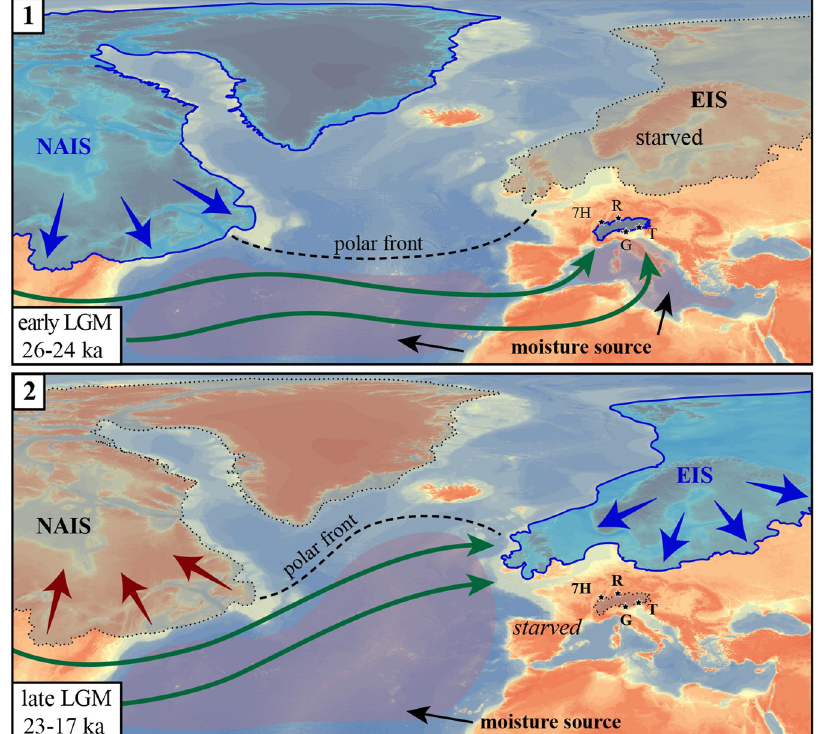
Figure 4. Schematic synthesis of the two phases of the LGM: (1) the topography of the NAIS produced changes in atmospheric circulation forcing the jet stream (green arrows) over southern Europe and the Mediterranean, which became an additional moisture source increasing precipitation over the Alps triggering synchronous Alpine glaciers advance; whereas the EIS waxing was slowed down. (2) The withdrawal of the NAIS at the increasing of the insolation drove the northward migration of the polar front, which move the advection towards the EIS and likely the Greenland; whereas the Alpine glaciers, underfed by precipitation, started to retreat. Maps are generated using CNR-licensed software ArcGIS 10.4 (http://www.esri.com/software/arcgis), and Adobe Illustrator CS5.1,